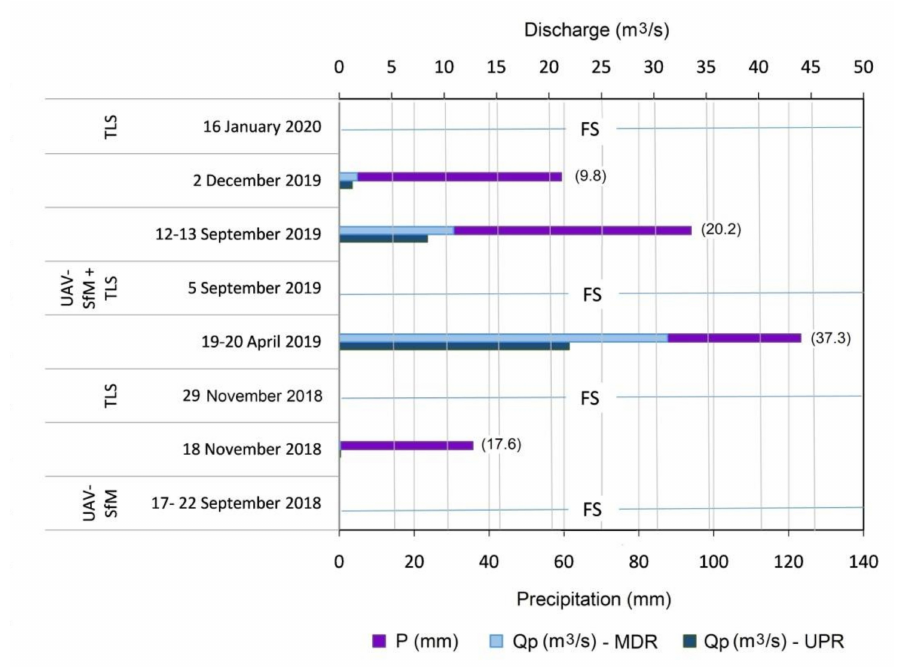
Figure 2. Chronogram of the flow events and of the field surveys (FSs) performed using either UAV-SfM (Structure from Motion based on information collected with UAVs), Terrestrial Laser Scanning (TLS), or the combination of the two techniques (UAV—SfM + TLS). P = precipitation (mm); Qp—MDR = peak discharge (m 3 s − 1 ) at the Middle Reach; Qp—UPR = peak discharge (m 3 s − 1 ) at the Upper Reach. In parentheses, the maximum rainfall intensity (mm h − 1